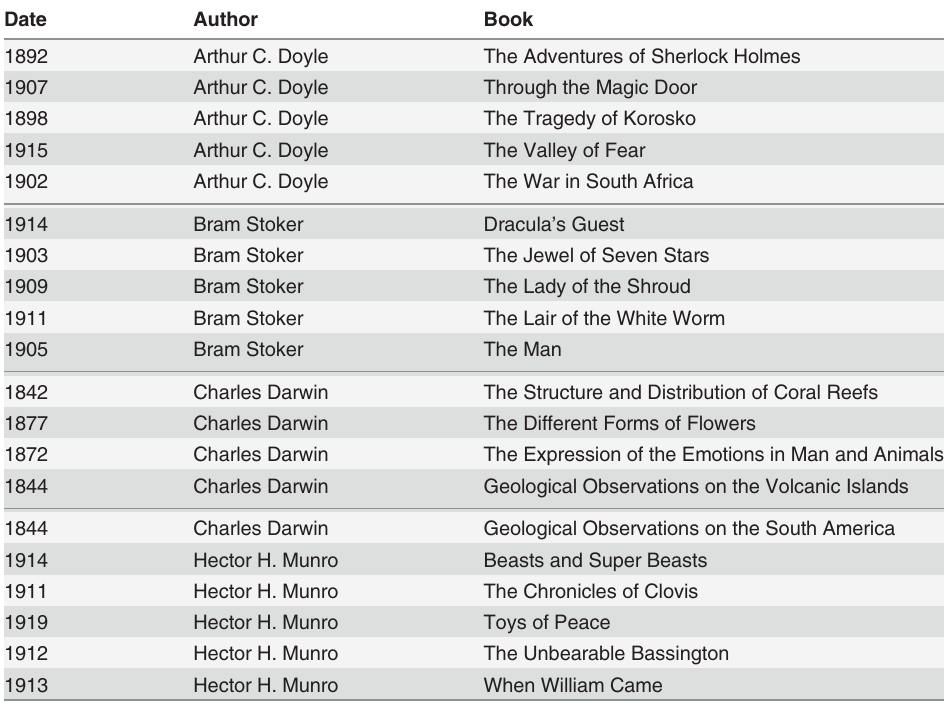
Table 3. List of books employed for the authorship recognitions